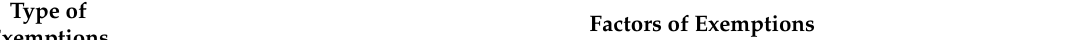
Table 3. Exemption of face mask by